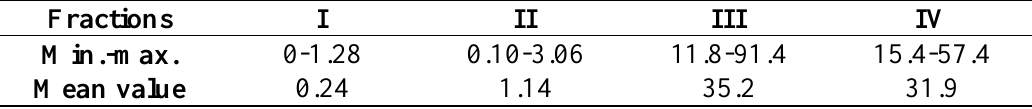
Table 2. Distribution of Cr (mg/kg) in fractions of sediments of Lake Skadar: